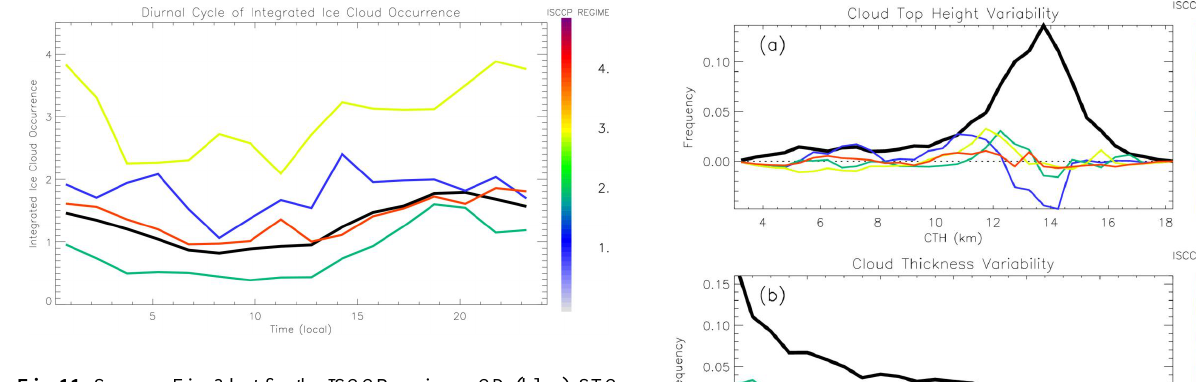
Figure 11: Same as Fig. 3 but for the ISCCP regimes: CD (blue), STC (green), CC (yellow), and MIX (red).